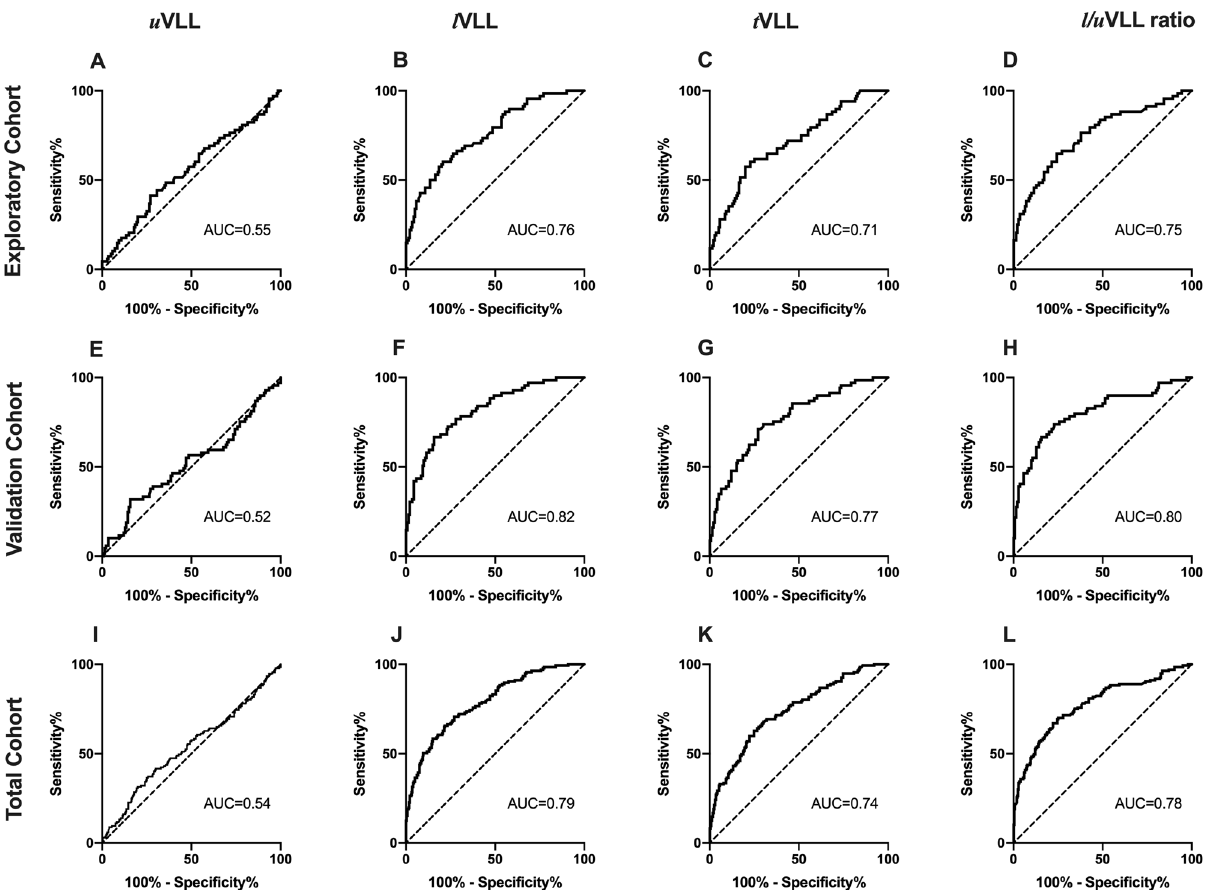
Figure 5. Receiver operating characteristic curves of vertical lung lengths (VLLs) for the detection of mild IIPs. Receiver operating characteristic curve analyses of VLLs for the detection mild IIPs (%predicted forced vital